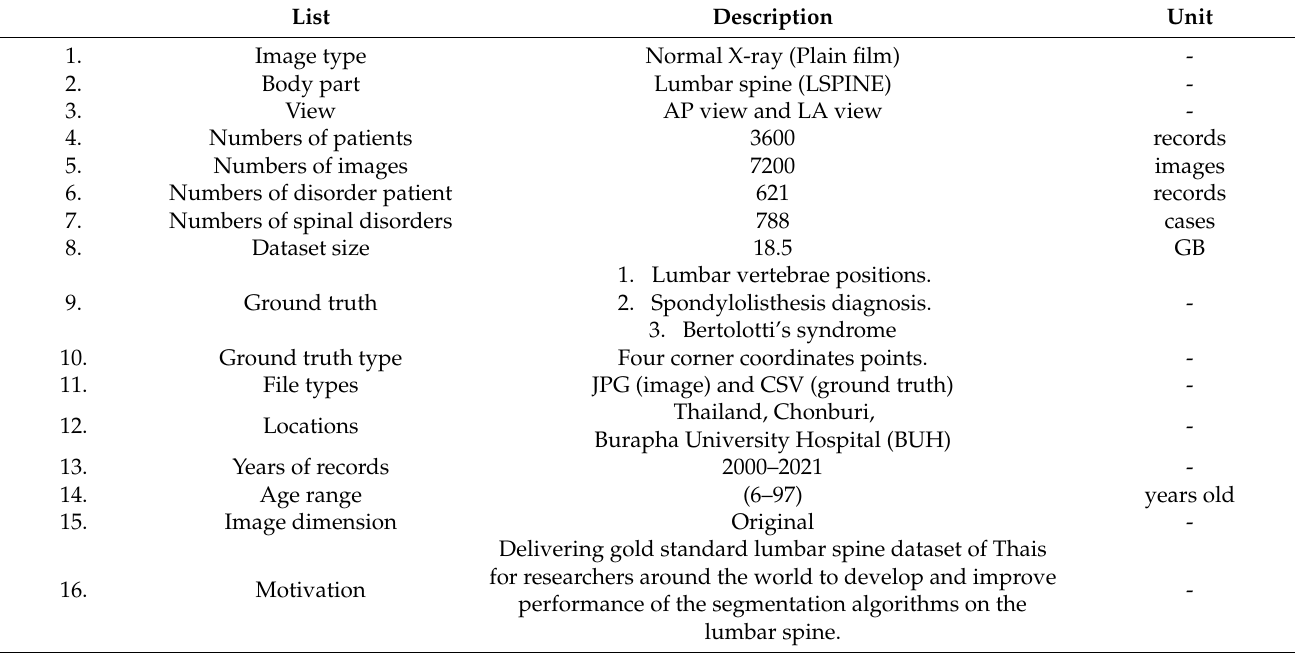
Table 1. Description of the experimented dataset which collected from Burapha University Hospi- tal, Thailand.